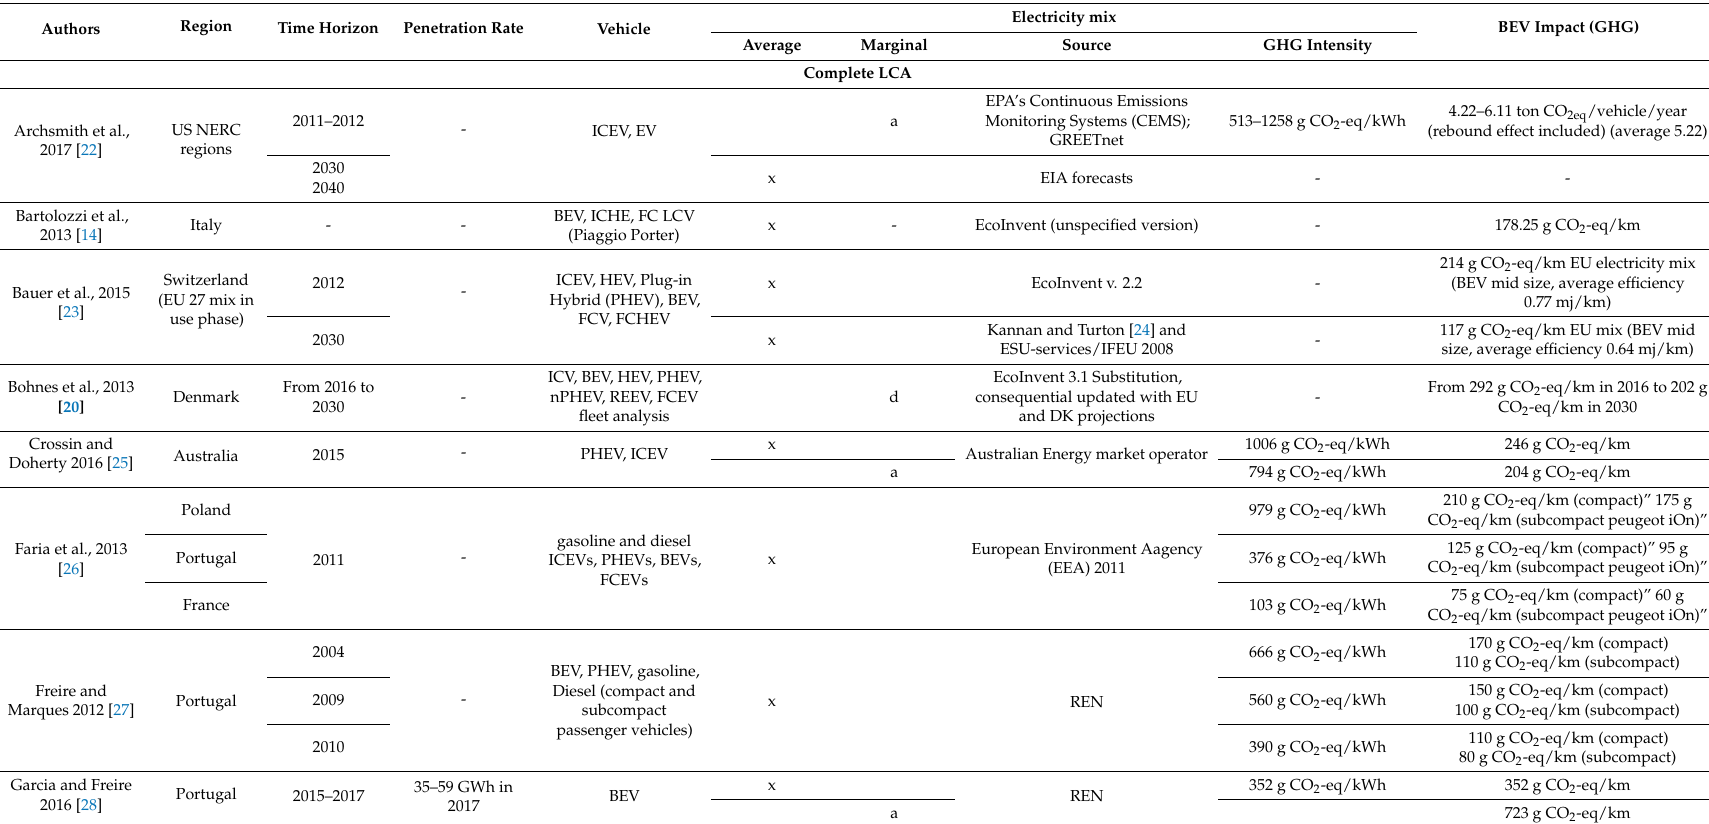
Table 1. Synoptic view of the literature